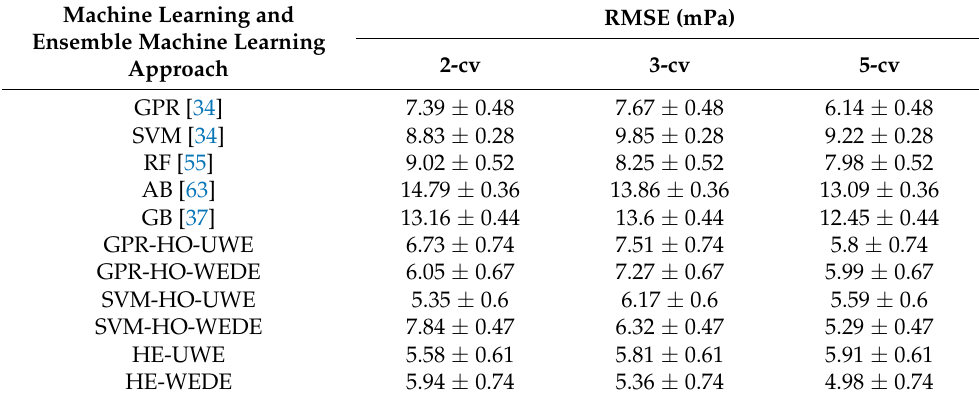
Table 9. K-fold cross-validation of the models with the training